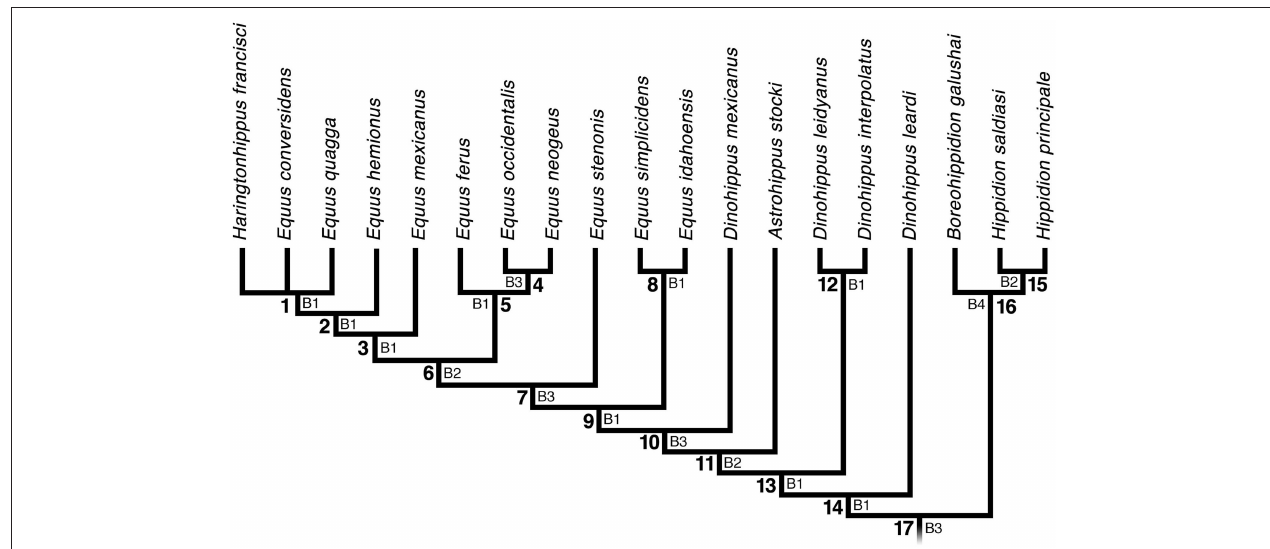
FIGURE 1 | Strict consensus of three equally most parsimonious cladograms of 85 steps, consistency index (CI) of 0.57 and retention index (RI) of 0.80 using a matrix of 32 morphological characters and 21 Equini taxa ( Table 1 ). Numbers beside nodes indicate Bremer support values. Outgroups ( Acritohippus stylodontus and Pliohippus pernix ) are not shown in the figure. Characters and character states are described in the Appendix.